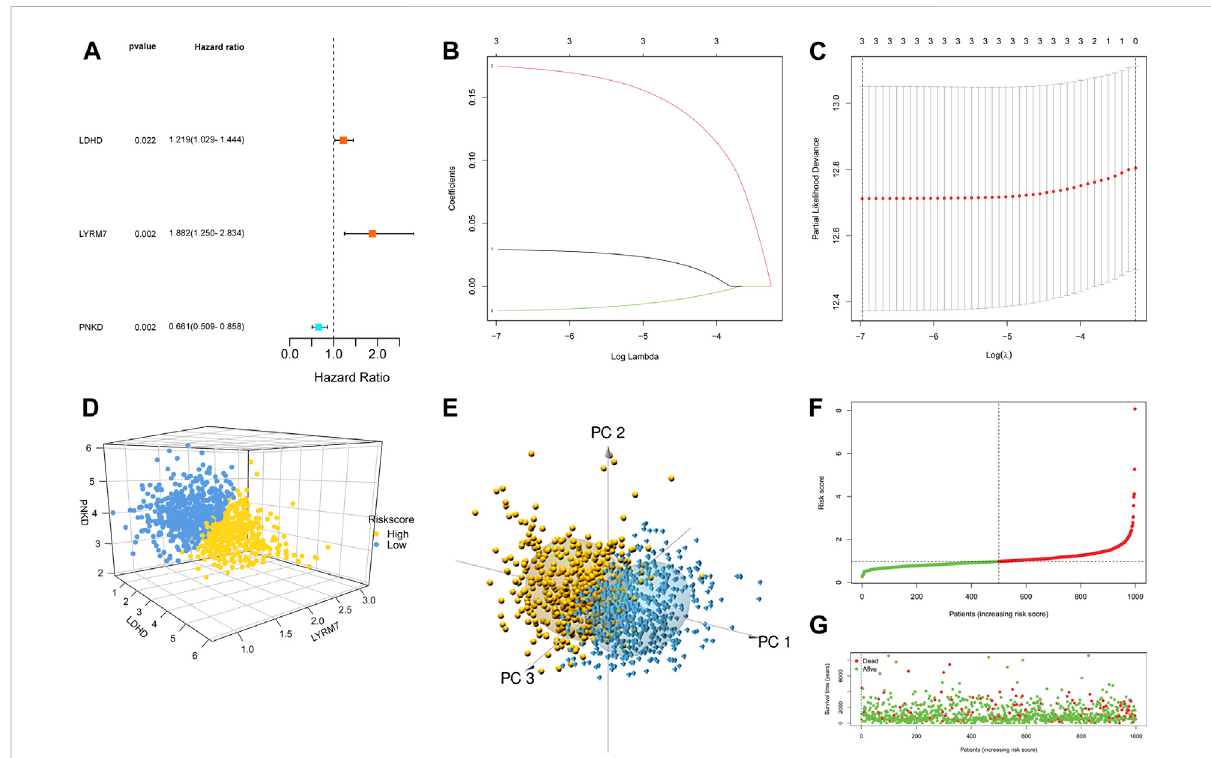
FIGURE 2 ConstructionoftheLMRGprognosticsignature. (A) Univariate Coxregressionanalysis of12LMRGs,andthreegeneswith p < 0.05. (B,C) LASSO regression analysis. (D) Two risk score groups were separated based on the expression of three genes. (E) PCA plot for OCs based on the risk score. (F,G) Risk score distribution and survival status of BCs based on the risk